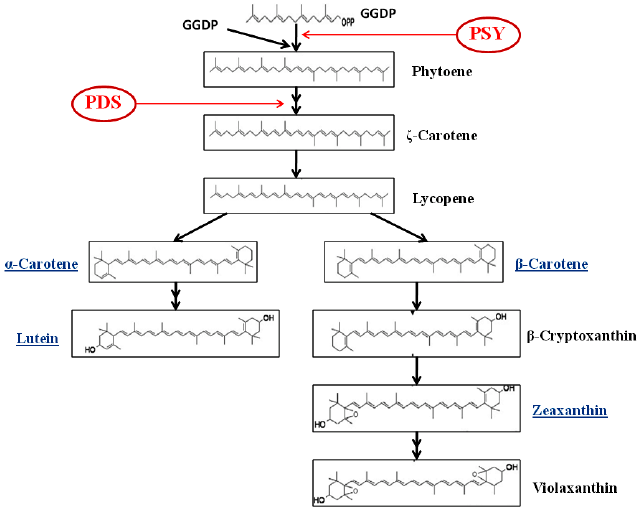
Fig. 1: Carotenoid biosynthesis pathway in plants. The activity of phytoene synthase (PSY) and phytoene desaturase (PDS) in the biosynthesis of carotenoids. Blue colour denotes the carotenoids measured in this study by HPLC analysis and red colour indicates enzymatic activi- ties for which gene expression was monitored via real time-PCR. GGDP, geranylgeranyl diphosphate.